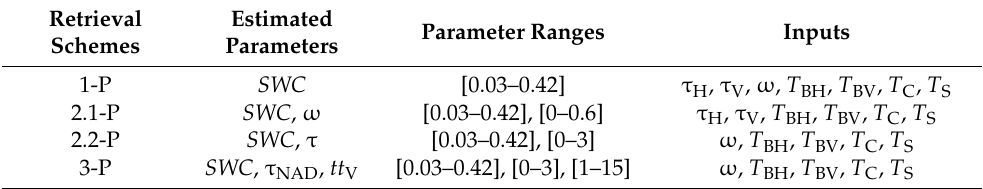
Table 1. Different retrieval schemes used to estimate the volumetric soil water content ( SWC ) [m 3 m − 3 ] from the brightness temperature ( T B ) measurements over the non-gridded plot using the τ - ω